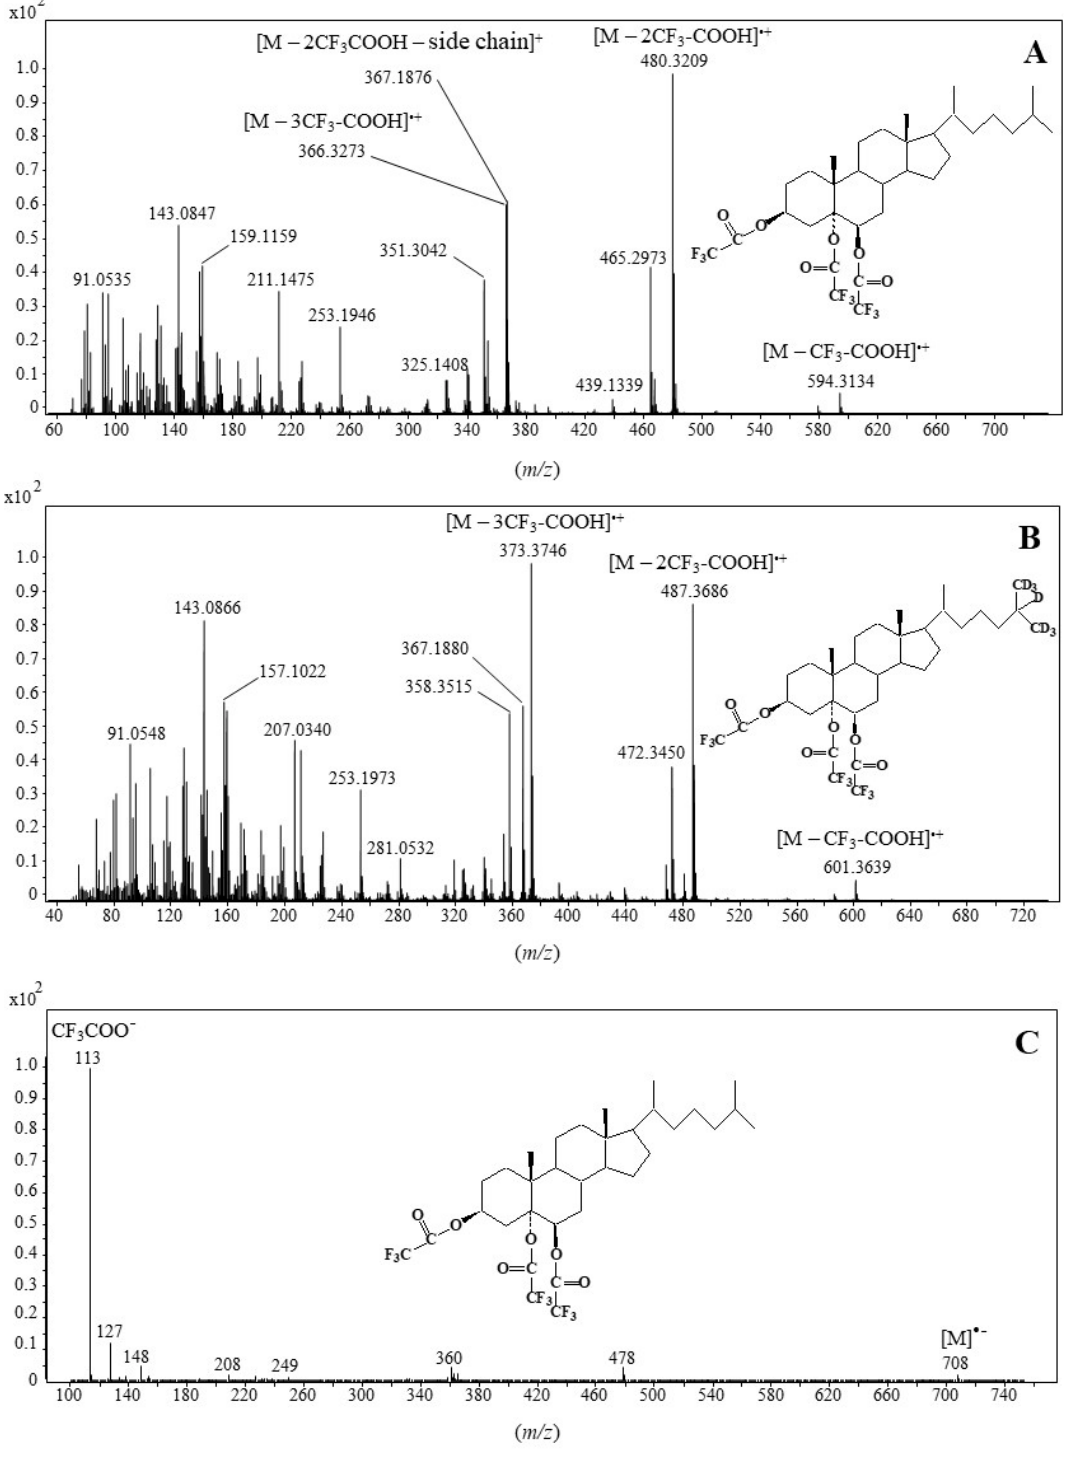
Figure 2. EI(TOF) mass spectra of cholesta-3 β ,5 α ,6 β -triol ( A ) and cholesta-25,26,26,26,27,27,27-d 7 - 3 β ,5 α ,6 β -triol ( B ) trifluoroacetate derivatives and electron-capture negative ionization (ECNI) mass spectrum of cholesta-3 β ,5 α ,6 β -triol trifluoroacetate derivative ( C ) (• = radical, • − = radical anion).